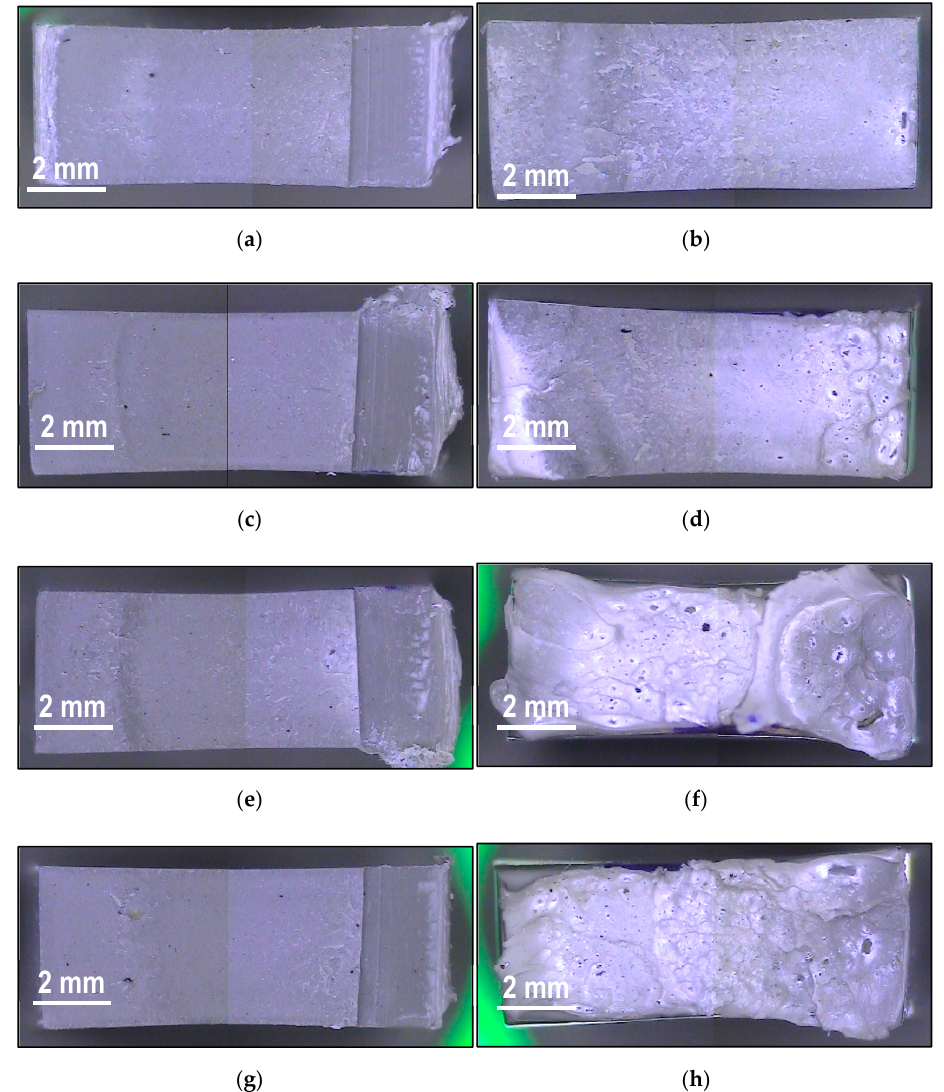
Figure 4. Optical micrographs of impact fractured surfaces of PP ( a , b ), PP-5OBC ( c , d ), PP-5SEBS ( e , f ), PP-5OBC-5SEBS ( g , h ). Images ( a , c , e , g ) referred to the notched specimens, the others to the unnotched ones.